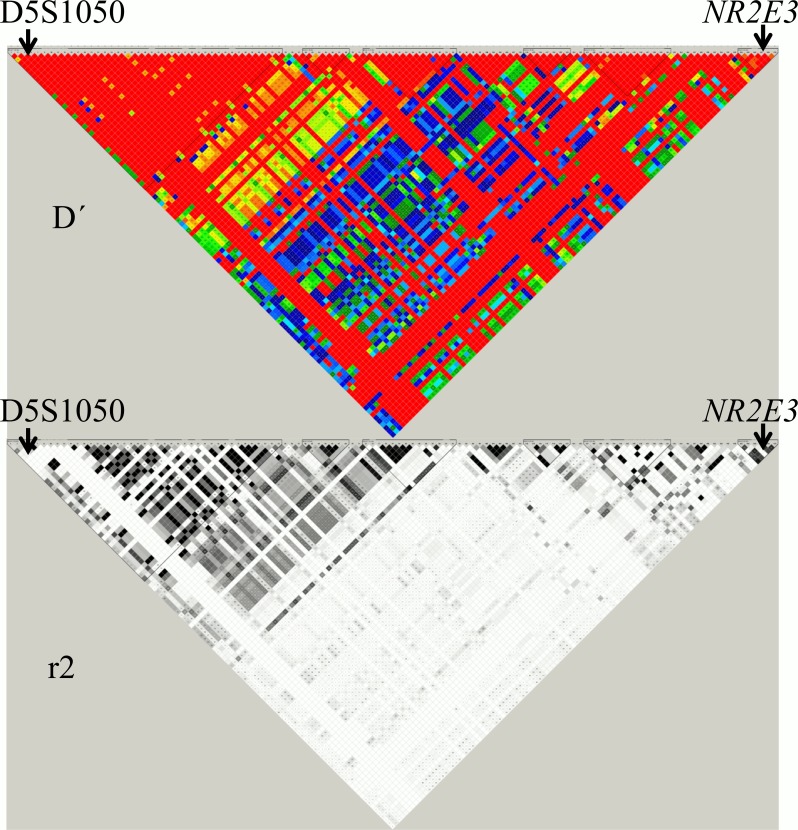
Linkage disequilibrium for region Chr15: 71,980,969–72,110,600 of the Human Genome Assembly GRCh37 (Hapmap/Haploview 4.0 software: http://www.hapmap.org/).Colour image: D´ (red: D´ = 1, the lower the D´ the further away from red). Black & white image: r2 (black: r2, the lower the r2 the further away from black).